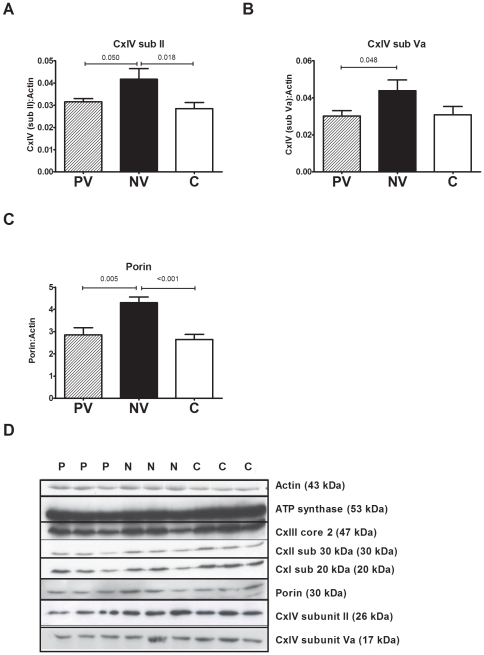
Western blot analysis of complex IV and porin expression in ADOA cell lysates show increases in normal vision ADOA patients.Total cellular protein was loaded onto a 12% acrylamide gel, transferred and probed with a suite of antibodies (Table S3). A,B) There was a significant increase in CxIV subunit II and IV content as well as C) porin in normal vision ADOA compared to poor vision ADOA and controls. However there was no change in expression of other OXPHOS enzymes including Complex I, Complex II, Complex III and ATP synthase (data not shown). D) A representative blot. Data is average +/− SEM. (P) poor vision (n = 8), (N) normal vision (n = 7), (C) controls (n = 21) for 3 independent experiments.